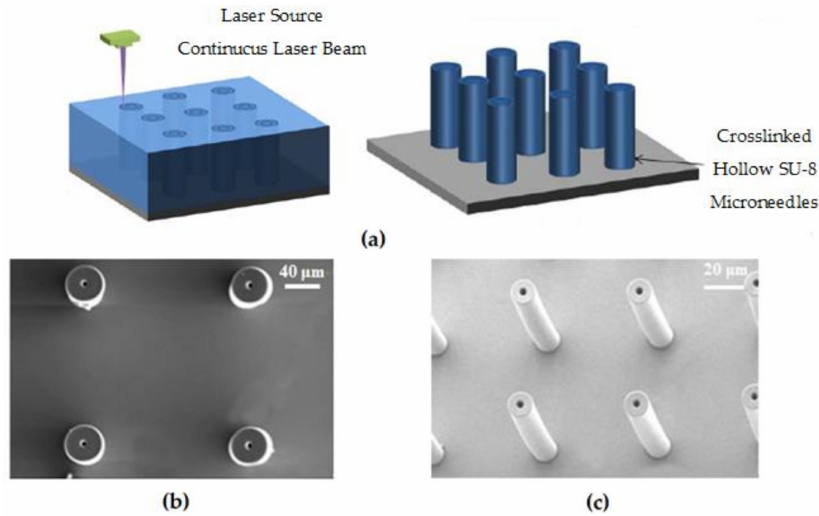
Figure 23. ( a ) Schematic diagram of DLW to fabricate SU-8 microneedle array; ( b ) the SEM top view of prepared SU-8 microneedle array; and ( c ) the SEM image of microneedle tilted at 20 ◦